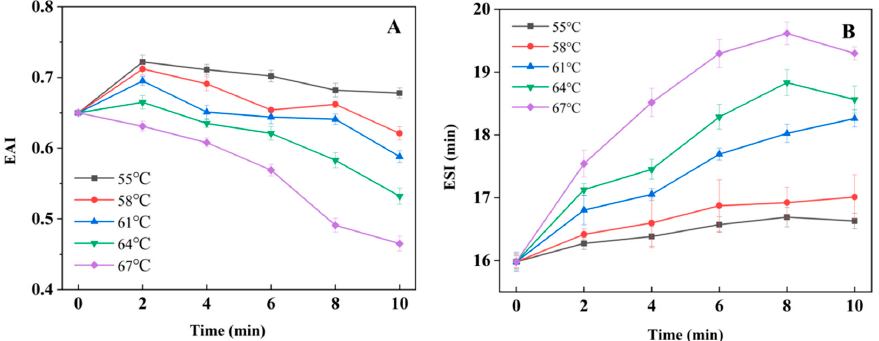
Figure 2. The effect of different heating treatment conditions on the emulsifying properties of LWE.